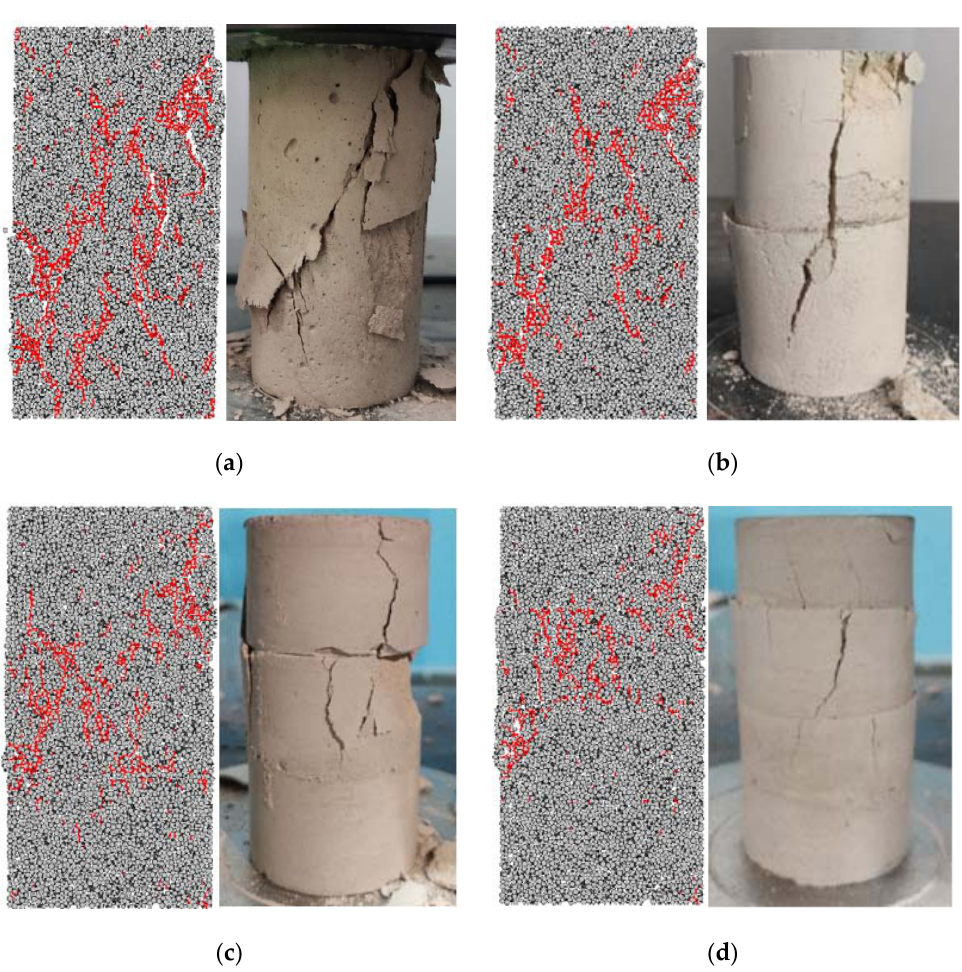
Figure 7. Failure mode of numerical model of horizontally layered filling body; ( a ) one layer, ( b ) two layers, ( c ) three layers, ( d ) four layers.